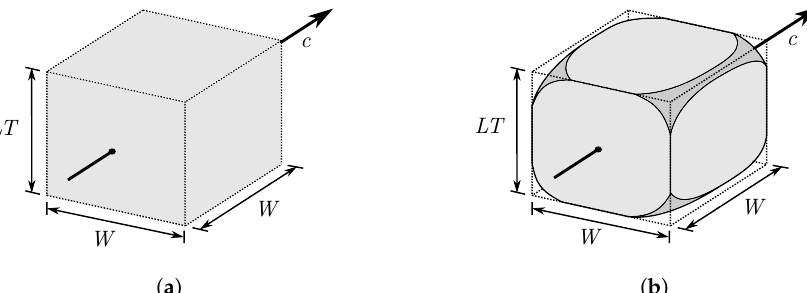
Figure 9. A representative volume element (RVE) is given for one droplet volume inside an additive manufactured part. ( a ): The ideal droplet volume in the slicing process. ( b ): The real droplet volume due to voids between the